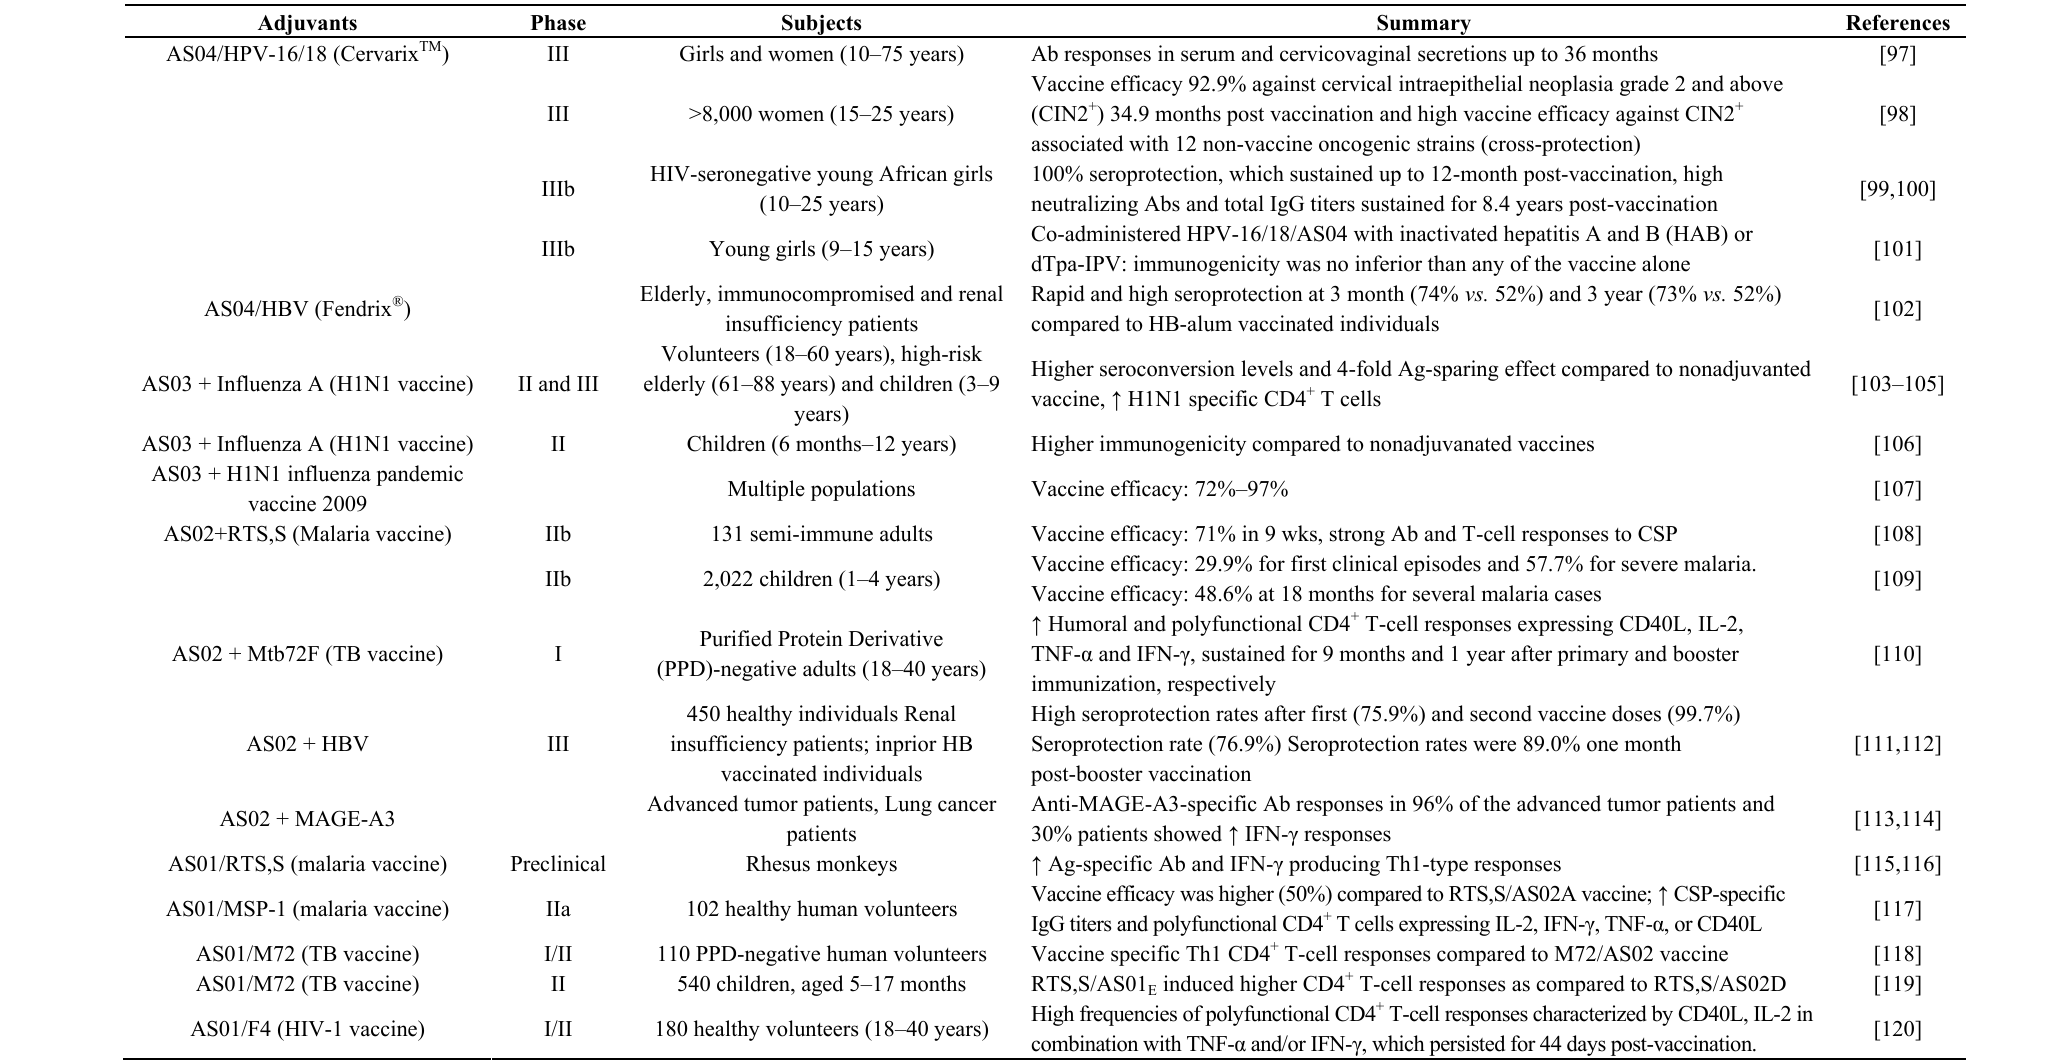
Table 3. Adjuvant system (AS): Clinical